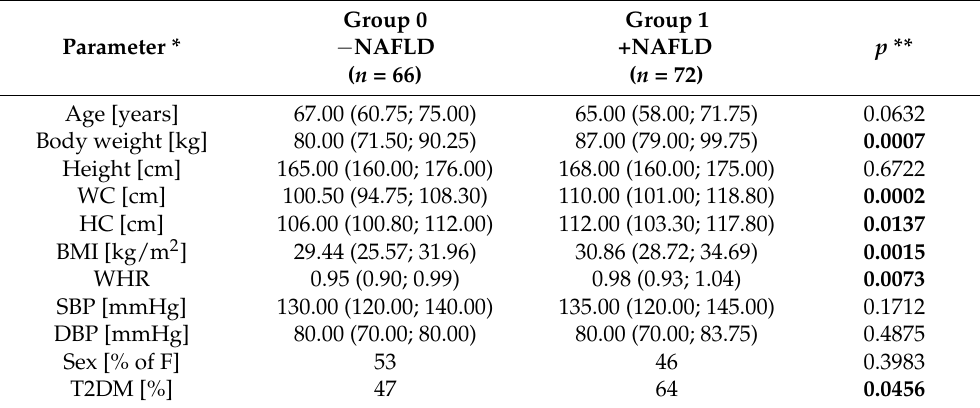
Table 1. Anthropometric characteristics of the study groups, including age, sex, blood pressure and presence of T2DM.